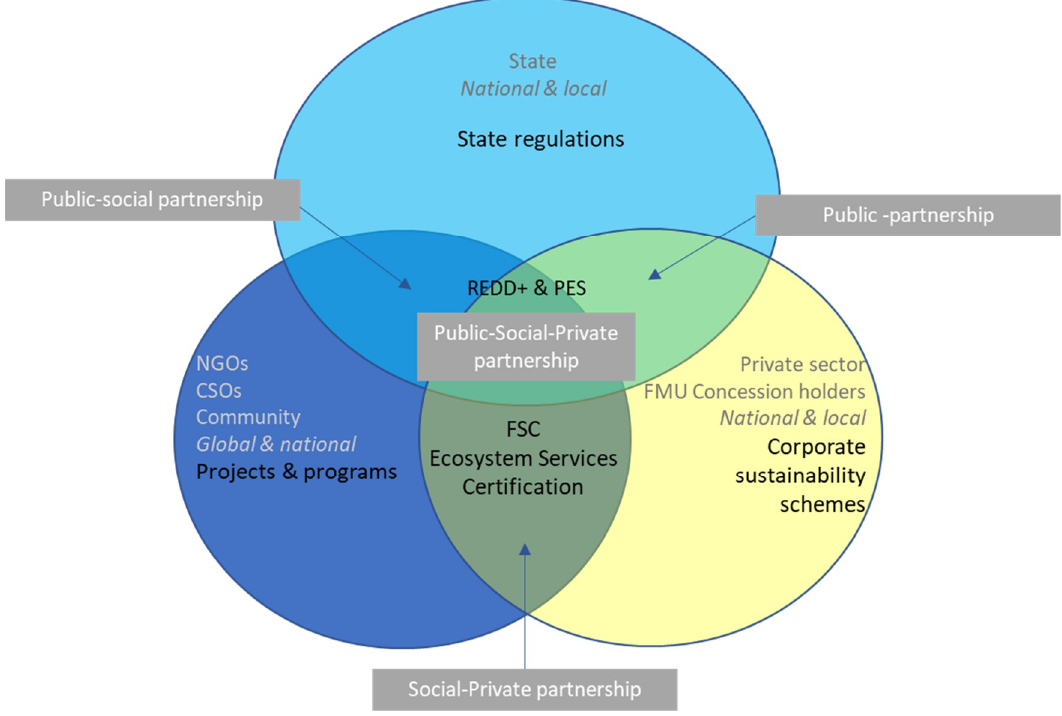
Figure 4. Forest Ecosystem Services Certification governance as a social-private partnership in Indonesia (inspired by Delmas and Young [27]).